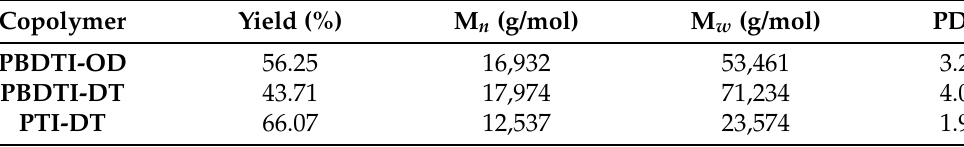
Table 1. Molecular weight and yield data of PBDTI-OD , PBDTI-DT and PTI-DT . Copolymer Yield